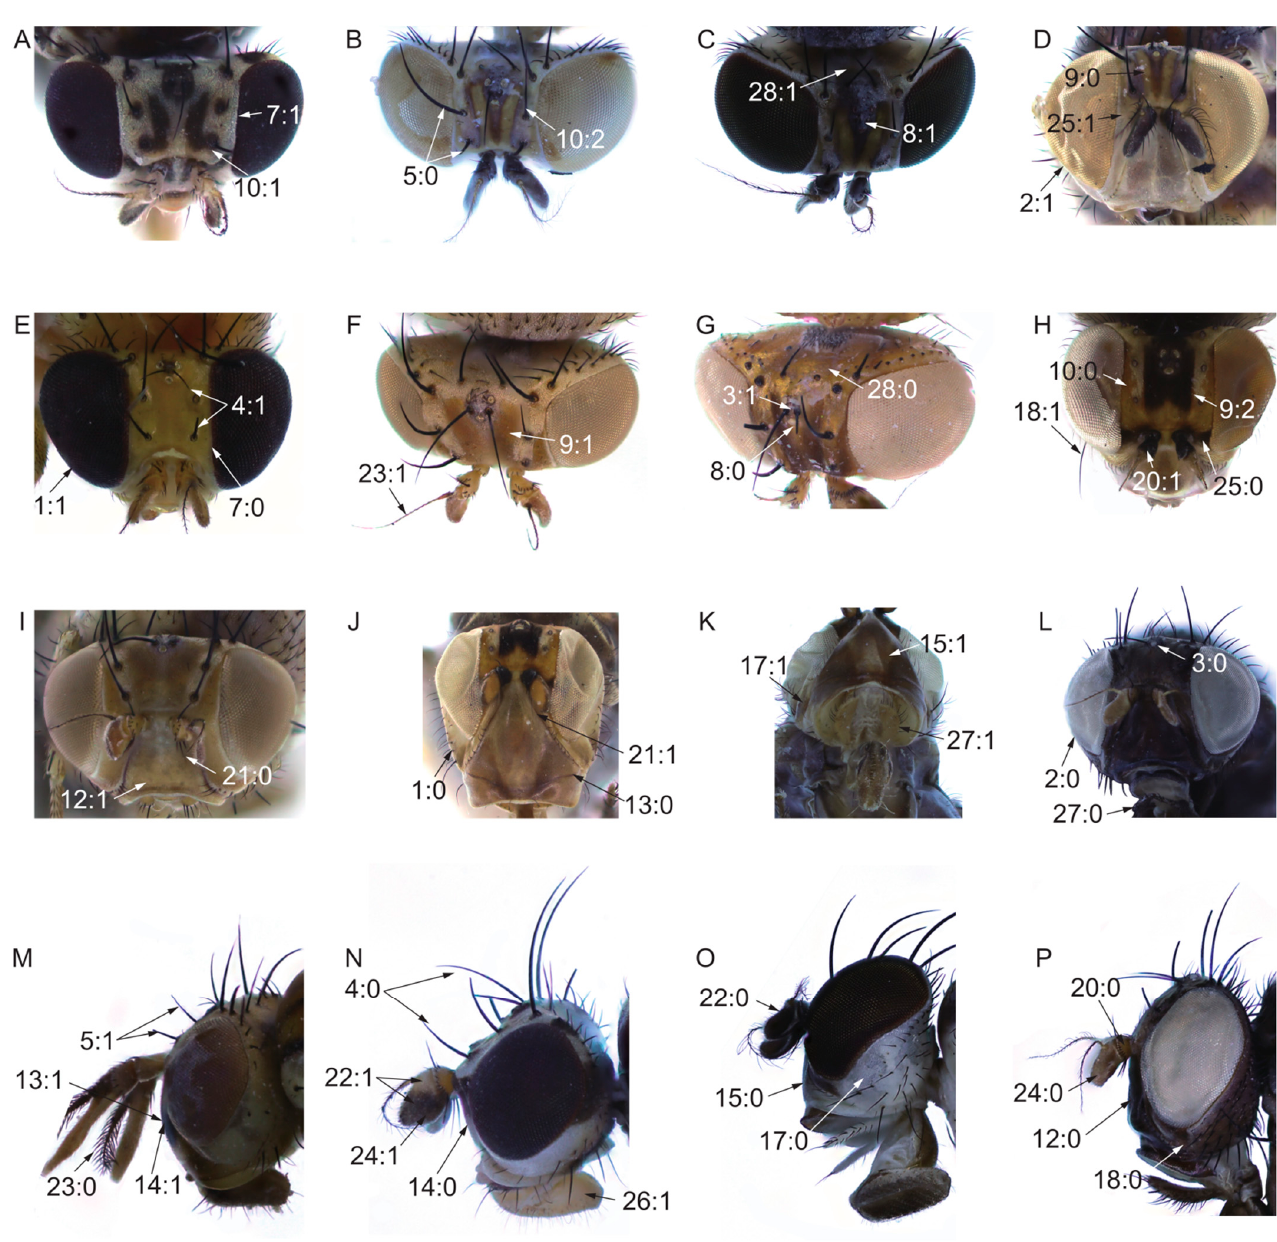
Figure 2. Hand characters. ( A , N ): Homoneura ( Homoneura ) picta ; ( B , C , D , O ): Homoneura ( Homoneura ) flavida ; ( E ): Homoneura ( Minettioides ) orientis ; ( F , I ): Homoneura ( Euhomoneura ) yanqingensis ; ( G ): Homoneura ( Neohomoneura ) tricuspidata ; ( H , J , K ): Prosopophorella yoshiyasui ; ( L , P ): Minettia ( Frendelia ) longipennis ; ( M ): Pachycerina decemlineata Thorax: 29. Color of mesonotum: (0) black (Figure 3A); (1) brown to yellow (Figure 3E). 30. Stripe on mesonotum: (0) present (Figure 3C); (1) absent (Figure 3E). 31. Base of dorsocentral seta and prescutellar acrostichal seta: (0) without spot (Figure 3D); (1) with spot (Figure 3B). 32. Pre-sutural dorsocentral seta; (0) absent (Figure 3A); (1) present (Figure 3D). 33. Post-sutural dorsocentral seta: (0) three, 1st post-sutural dorsocentral setae behind the transversal suture (Figure 3E); (1) three, 1st post-sutural dorsocentral setae in the transversal suture; (2) two (Figure 3D).